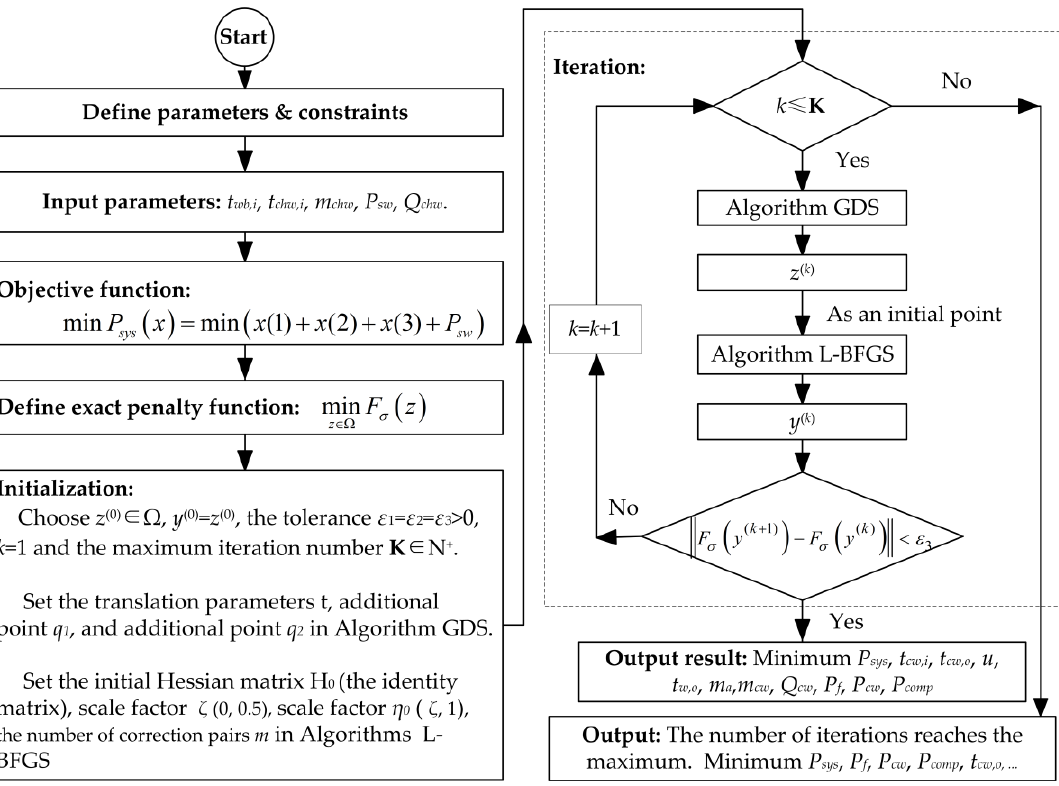
Figure 2. Flowchart of the optimization approach based on hybridizing L-BFGS with GDS algorithms.